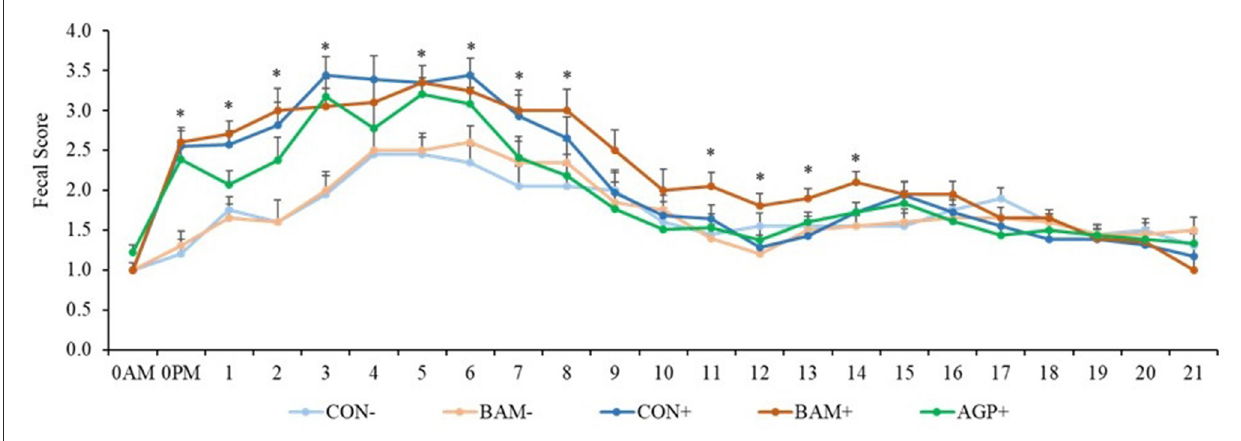
FIGURE1 The daily fecal score of weaned pigs fed diets supplemented with Bacillus amyloliquefaciens (BAM) or antibiotics (AGP) with or without enterotoxigenic Escherichia coli challenge. Fecal score = 1, normal feces; 2, moist feces; 3, mild diarrhea; 4, severe diarrhea; 5, watery diarrhea. PI, post-inoculation. * P < 0.05, indicating diarrhea scores were different among treatments. Each least squares mean represents 9–10 observations.